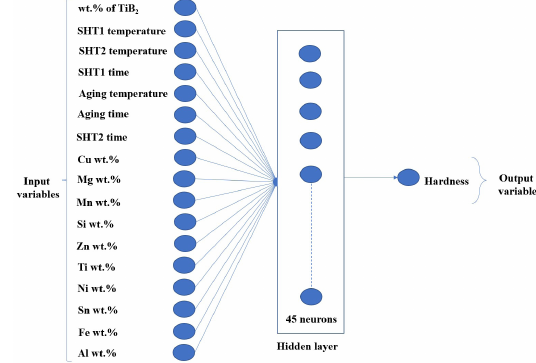
Figure 3. Structure of ANN model used in present